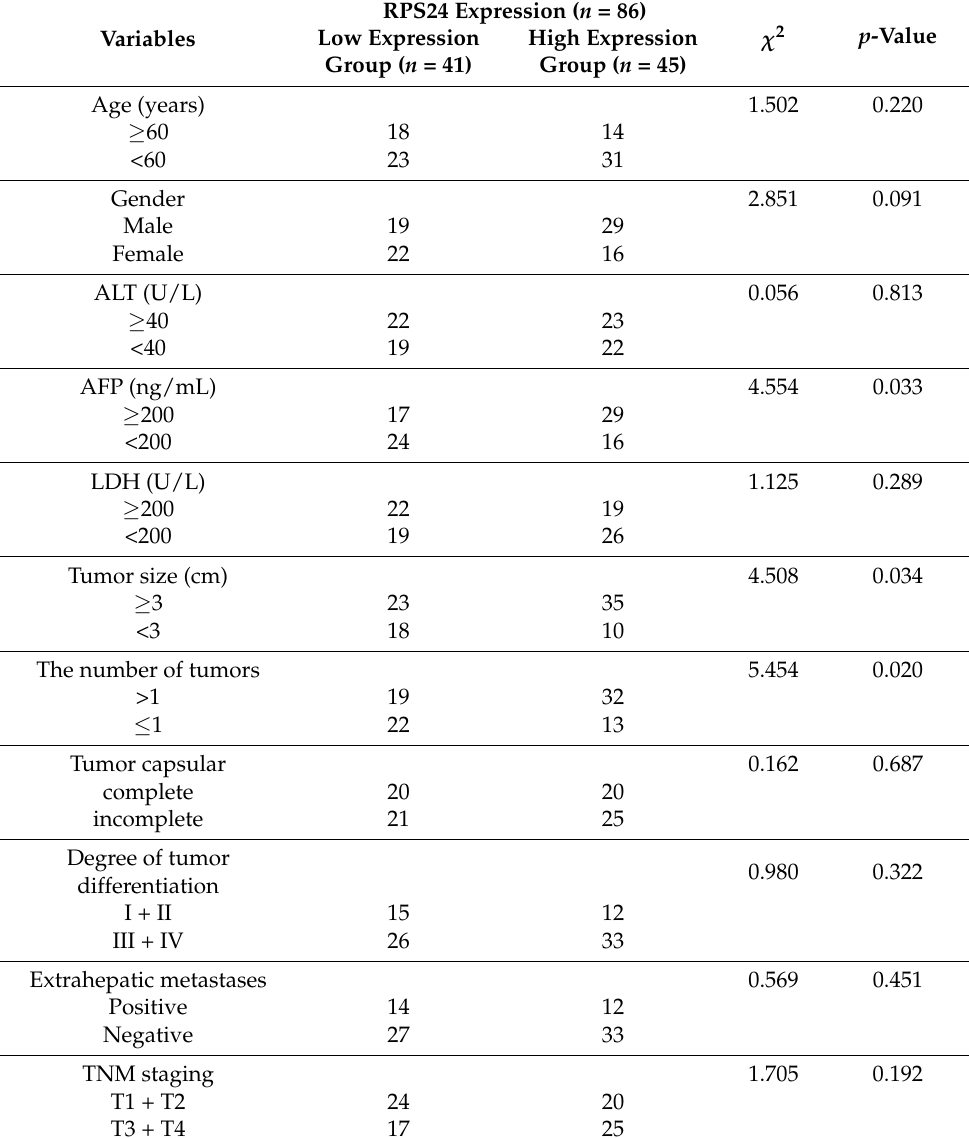
Table 3. Relationship between RPS24 expression and clinical features of patients with